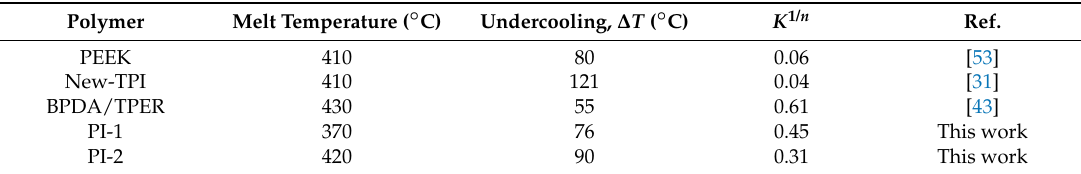
Table 3. Bulk crystallization rates for some semicrystalline polymers.